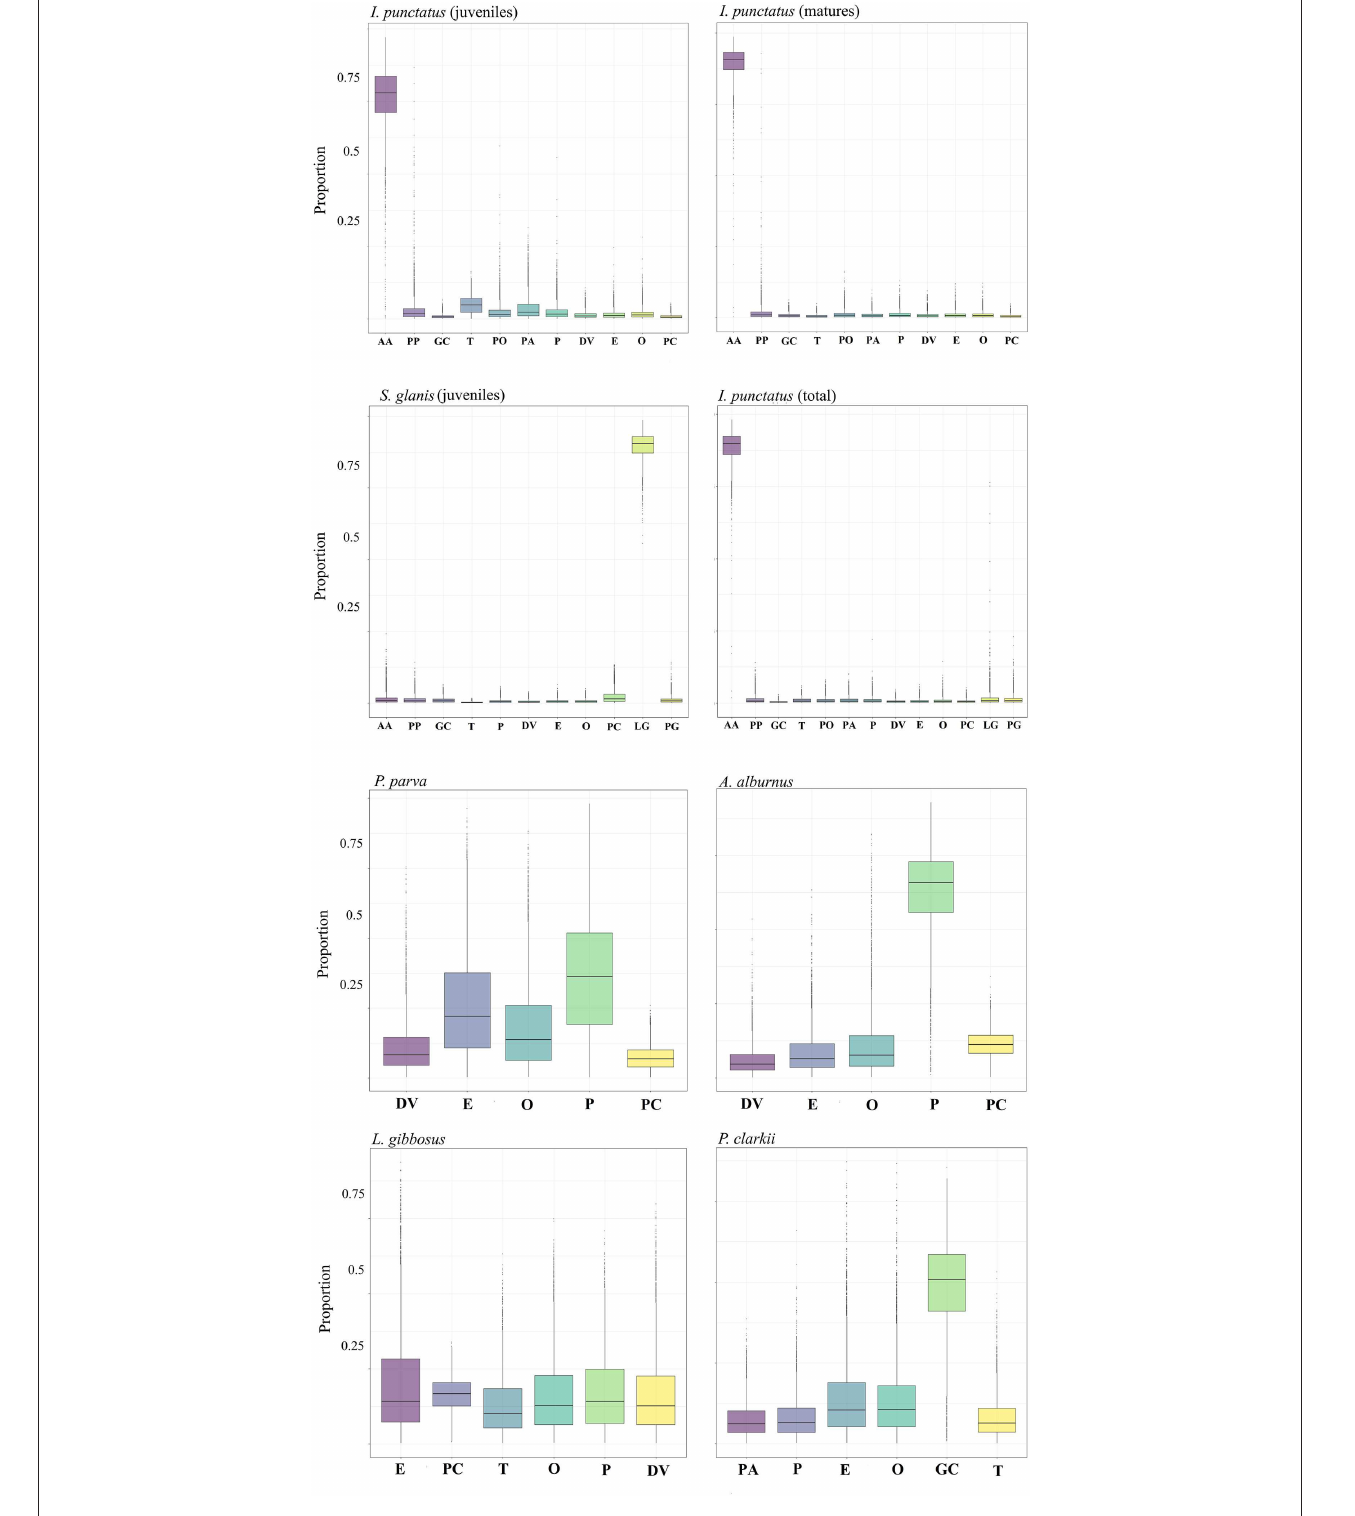
FIGURE 2 | Estimated proportions of prey items to the diet of: Ictalurus punctatus (juveniles), Ictalurus punctatus (matures), Ictalurus punctatus (total), juvenile Silurus glanis , Pseudorasbora parva , Alburnus alburnus , Lepomis gibbosus , and Procambarus clarkii . Prey items were considered those belonging to lower trophic levels without consideration of any prior. The analysis was performed using the R-package “simmr”.